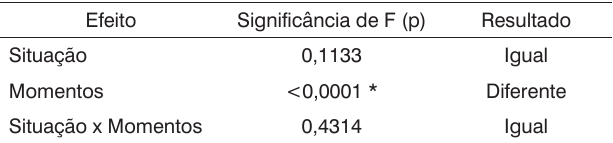
Tabela 6. Resultados do Teste de Análise de Variância (ANOVA) para a relação PS/PA